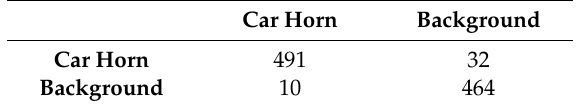
Table 7. Confusion matrix of the CNN model before compression.